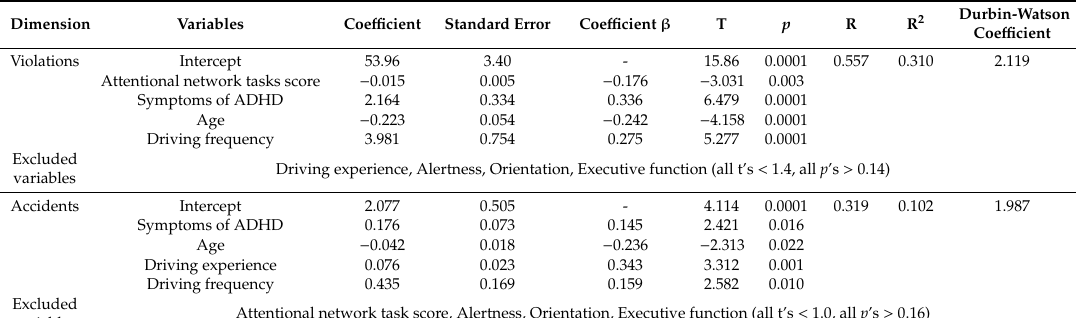
Table 2. Multiple linear regressions with tra ffi c violations and number of accidents as dependent variables, and age, symptoms of ADHD, driving frequency, driving experience, attentional network tasks, and their functions as